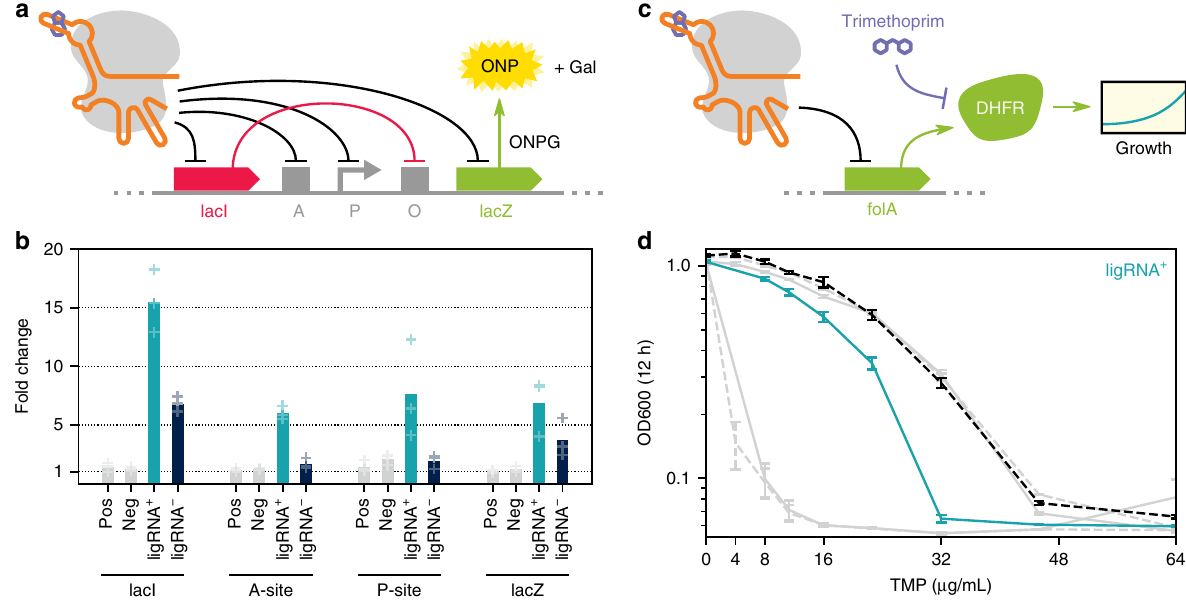
Fig. 3 ligRNAs function in the context of the endogenous loci in different bacteria. a Schematic showing sites in the E. coli lac operon (the genes lacI and lacZ , the transcriptional operator sites A and O, and the promoter P driving LacZ expression) targeted by ligRNAs (black arrows). Note that LacI inhibits expression of LacZ (red arrow), so the ligRNAs targeting lacI are expected to increase LacZ expression when active (Supplementary Fig. 9). Expression of LacZ is detected by conversion of o-nitrophenol- β -D-galactopyranoside (ONPG) into o-nitrophenyl (ONP, yellow) and galactose (Gal). b Fold change in LacZ activity for E. coli grown with or without theophylline, expressing either a control sgRNA (pos or neg, grey), ligRNA + (teal), or ligRNA − (navy), with spacers targeting the indicated part of the lac operon. Spacer sequences were taken from Qi et al . 2 and are listed in Supplementary Table 4. Bar heights represent the mean of three biological replicates. Data for each replicate are shown as faded plus marks. The direction of the fold change (i.e. holo/apo or apo/holo) was chosen such that the resulting value is greater than one. ligRNA + responds to theophylline for all 4 spacers, while ligRNA − does so only for the two genes lacZ and lacI . c Schematic illustrating a growth assay in P. aeruginosa with ligRNA + targeting the endogenous dihydrofolate reductase (DHFR) gene ( folA ). DHFR is neccesary for growth (green arrows) in the absence of thymidine, and is inhibited by the antibiotic trimethoprim (purple arrow). d Growth (OD600) of P. aeruginosa at 12 h in the presence (teal, solid) and absence (black, dashed) of theophylline at the indicated concentrations of trimethoprim (TMP). Inhibition of FolA by ligRNA + in the presence of theophylline lowers the minimum concentration of trimethoprim needed to slow growth. Controls are in grey (high MIC: wildtype; low MIC: optimized sgRNA scaffold) and are also in the presence (solid) and absence (dashed) of theophylline. The spacer sequence is listed in Supplementary Table 4. Error bars are standard deviations of at least three biological